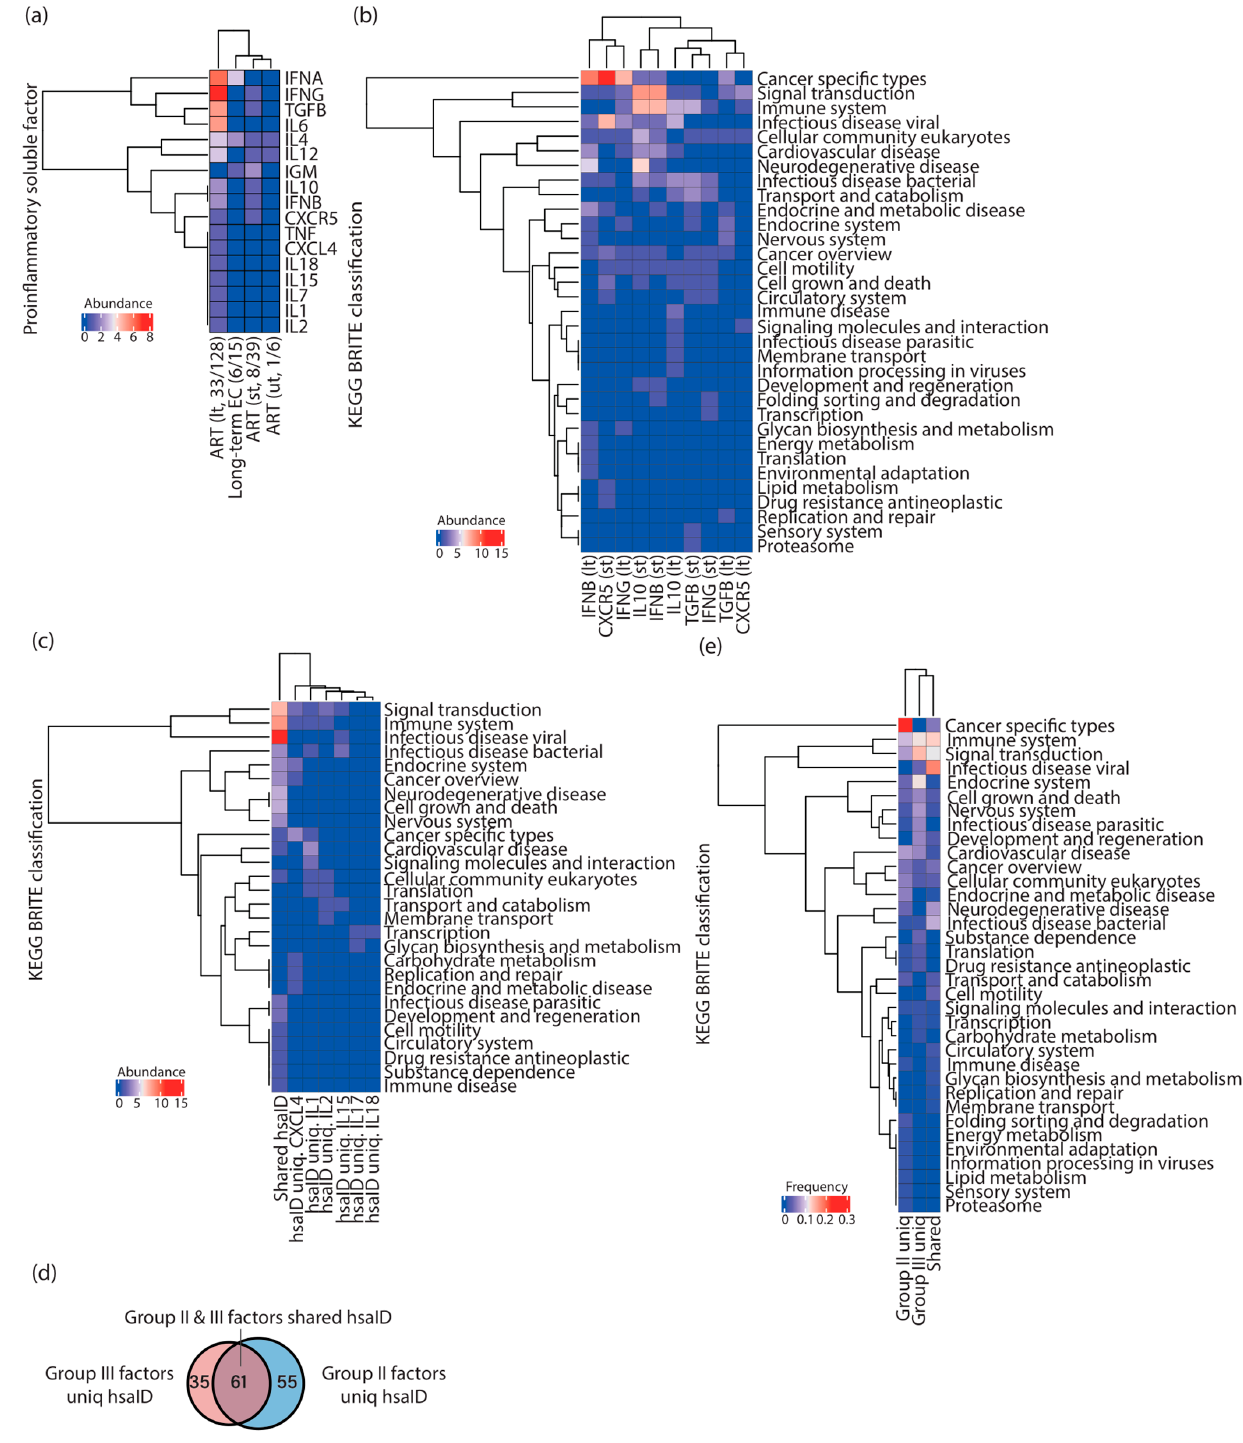
Figure 2. Different compositions of proinflammatory soluble factor signatures were present alongside HIV-1 infections associated with ART. ( a ) Cluster heatmap representing the abundance of proinflammatory soluble factors present in unique immunologic signatures enriched in HIV-1-infected individuals and elite controllers. Parentheses placed under the column indicate the number of proinflammatory soluble factors from the total signatures. ( b ) Cluster heatmap representing the abundance of each KEGG BRITE classification harboring enriched pathways related to group II factors in HIV-1-infected individuals after a short (st) and a long (lt) period of ART. ( c ) Cluster heatmap representing the abundance of each KEGG BRITE classification harboring enriched pathways